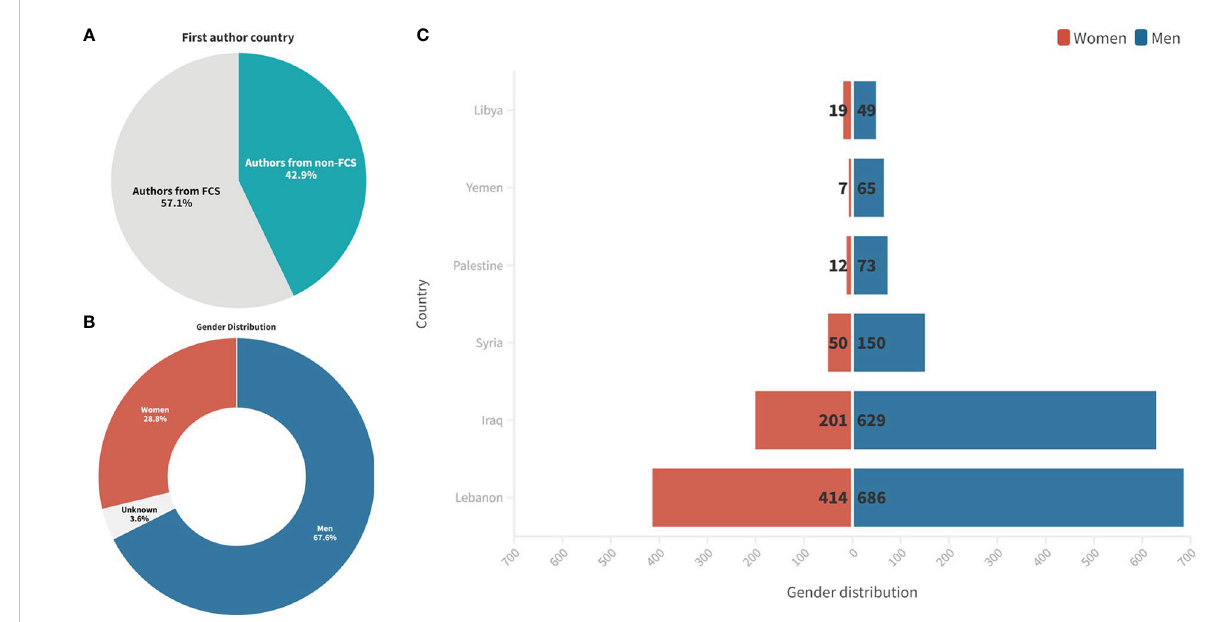
Figure 4) occurring 329, 183, 156, and 105 times, respectively (data